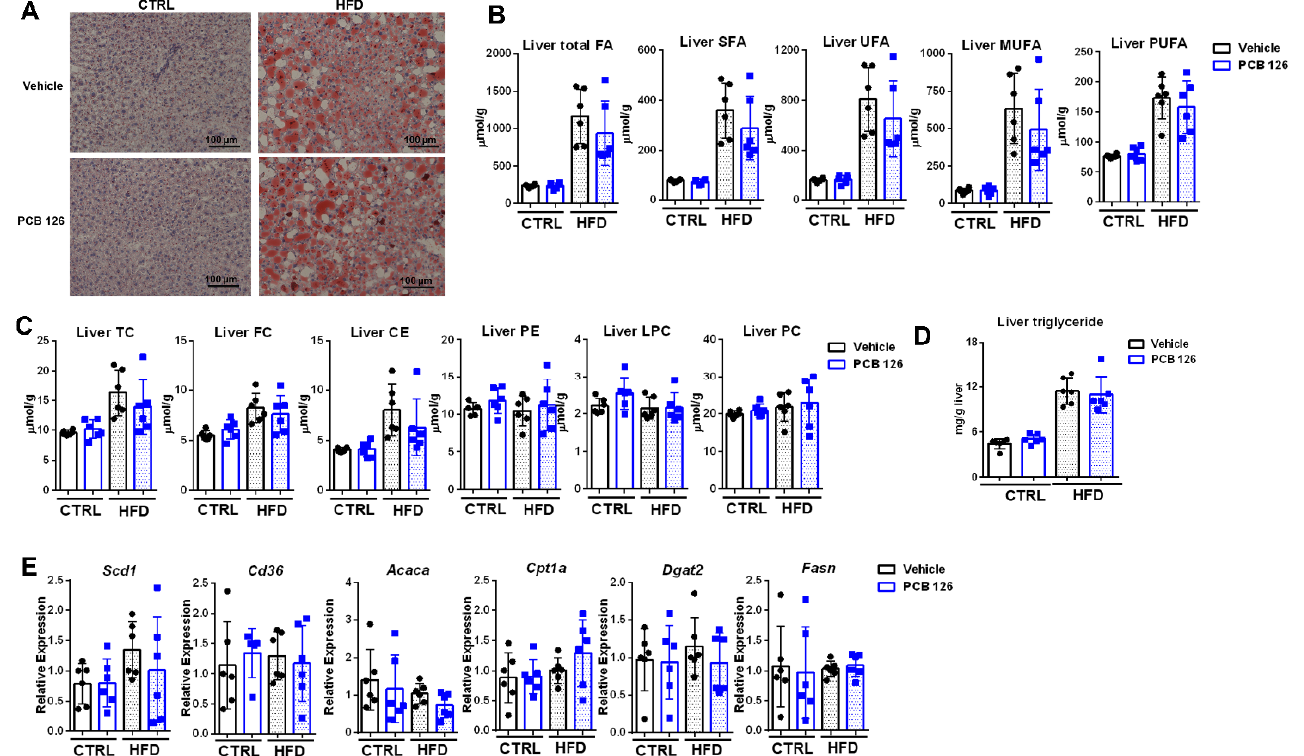
Figure 3. Effects of early life PCB 126 on liver lipid metabolism in mice with CTRL or HFD. ( A ) Oil Red O staining in the liver of CTRL or HFD ‐ fed mice with vehicle or PCB 126 exposure. ( B , C ) Quan ‐ titative 1 H NMR analysis of liver fatty acid ( B ) and lipid ( C ) profiling from CTRL or HFD ‐ fed mice with vehicle or PCB 126 exposure. ( D ) Liver triglyceride levels from CTRL or HFD ‐ fed mice